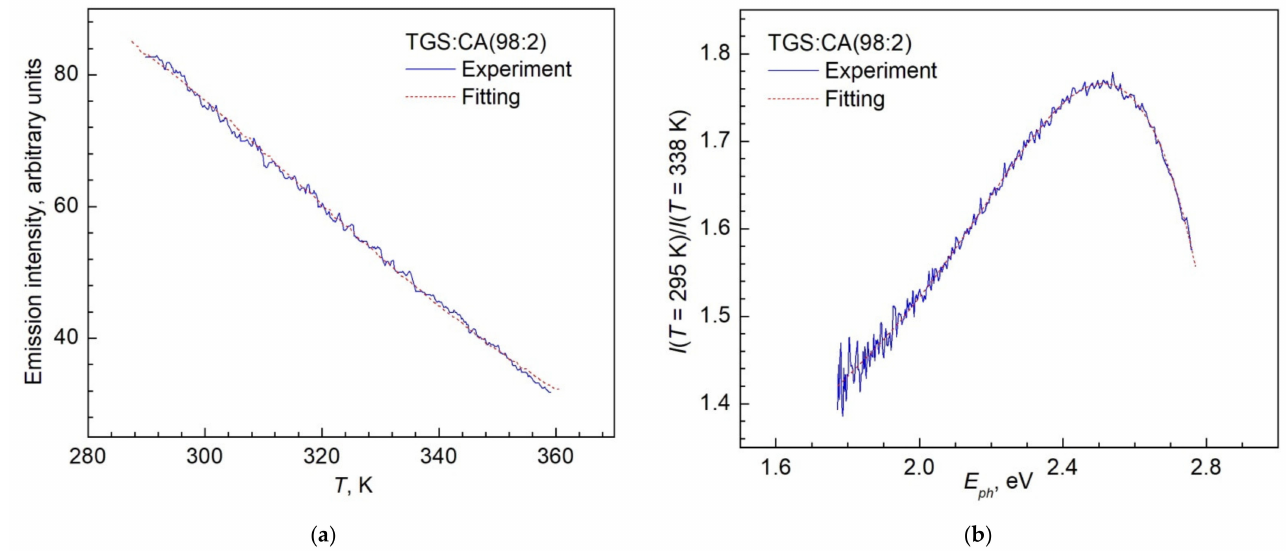
Figure 9. ( a ) The PL emission intensity dependence on the temperature, I ( T ), at the maximum of the emission band ( λ max = 507 nm ( E ph ≈ 2.48 eV)). ( b ) Experimental relationship between fluorescence intensities ratio at T = 295 K and 338 K, I ( T = 295 K)/ I ( T = 338 K) and photon energy (related to emission wavelength) for the excitation wavelength λ exc = 405 nm ( E exc ph ≈ 3.06 eV). Solid blue lines in panels ( a , b ) are experimental dependences and dotted red lines show the fits of the experimental data by Equation